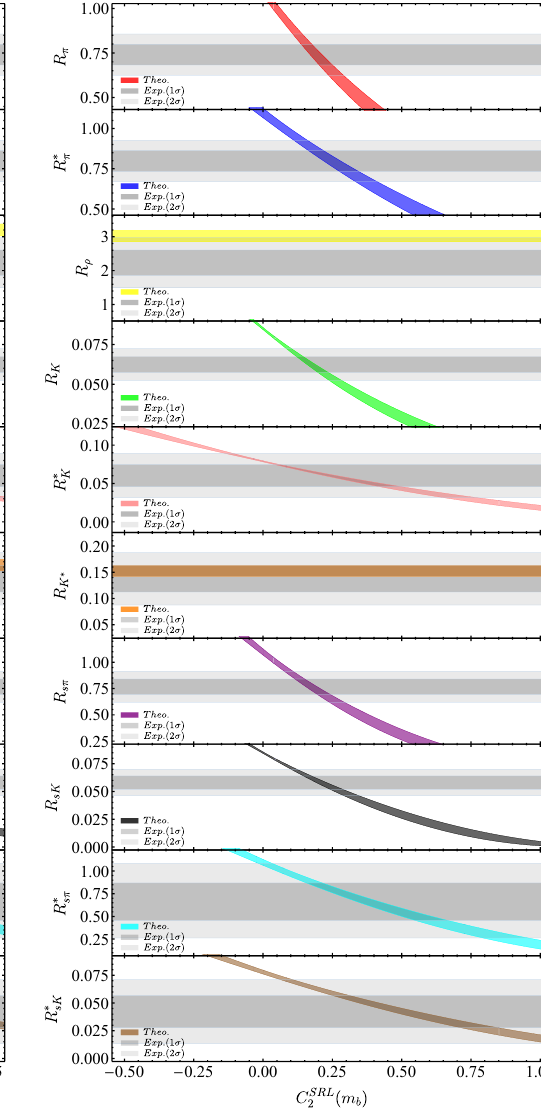
( m b ) (left) and C SRL